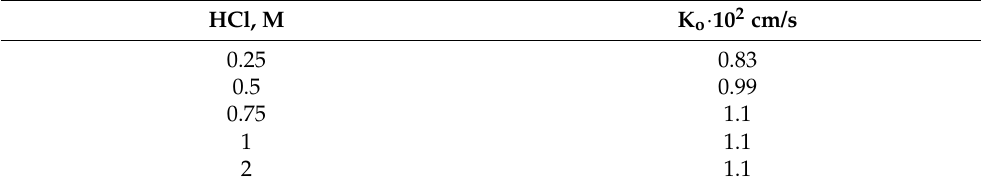
Table 1. Influence of HCl concentration on chromium(VI) transport. HCl, M